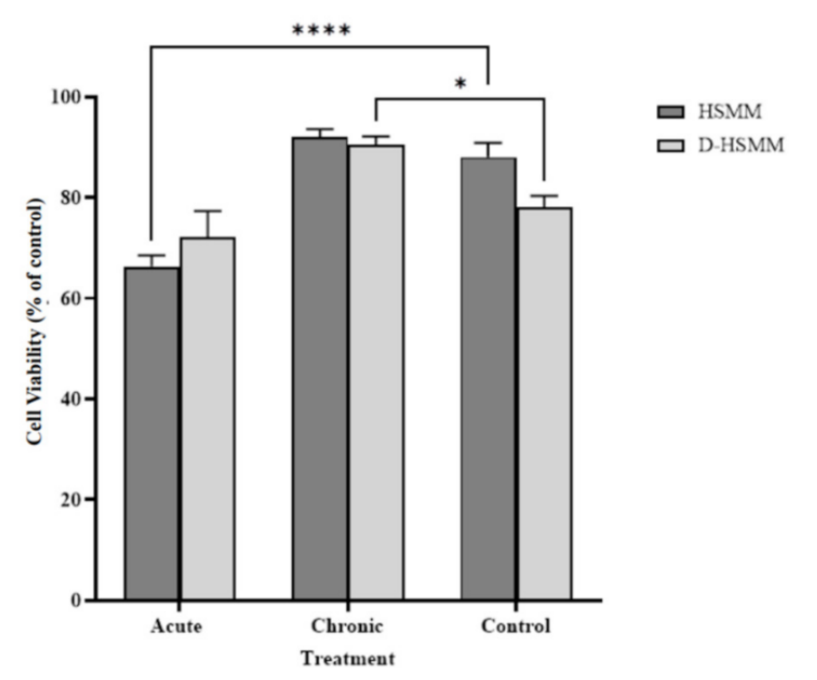
Figure 1. Following the acute and chronic heat treatments, cell viability percentage increased following the chronic treatment but decreased following the acute treatment. The asterisk (*) indicates significant change to the control, where * is p < 0.05 and **** is p <